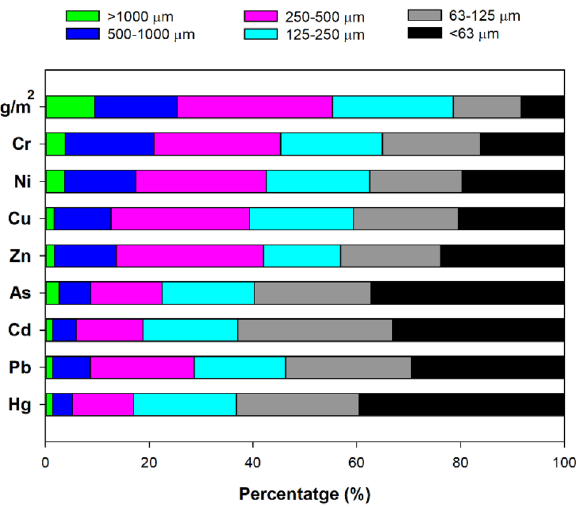
Figure 6. PTEs loading percentages of different sizes of road deposited sediments in this